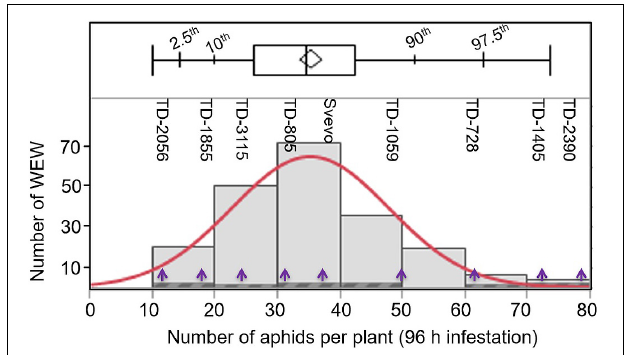
FIGURE 1 | Distribution of 203 wild emmer wheat (WEW) accessions according to their aphid performance. The total aphids per plant (X-axis) were evaluated after 96 h following infestation using a whole cage bioassay ( n = 8). The distribution ranged from 10 to 80 aphids per plant using the Shapiro–Wilk test shown in red color ( p < 0.0025). The plot above the histogram displays the quantile box plot with quantile marks (2.5th, 10th, 90th, and 97.5th quantile). The Y-axis represents the number of WEW genotypes in each bin. The purple arrows indicate the nine selected WEW accessions further used in this